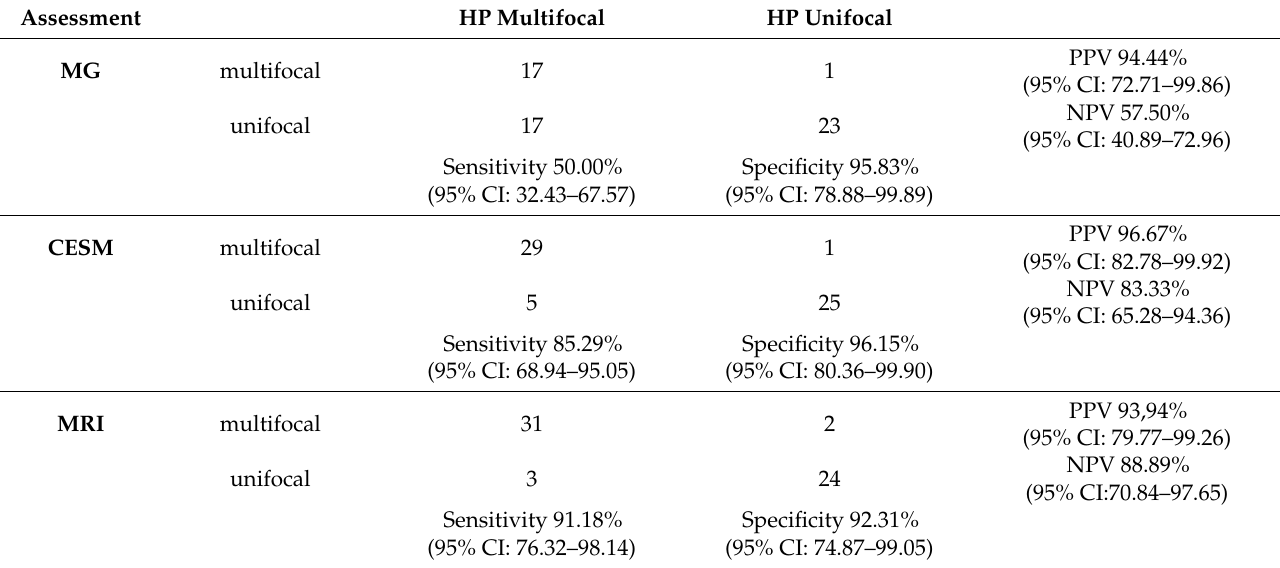
Table 1. Compliance of MG, CESM, and MRI in terms of detecting MFMCC, confirmed in postoperative histopathological examination.